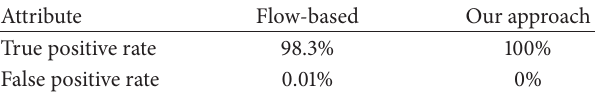
Table 5: Comparison of flow-based and our